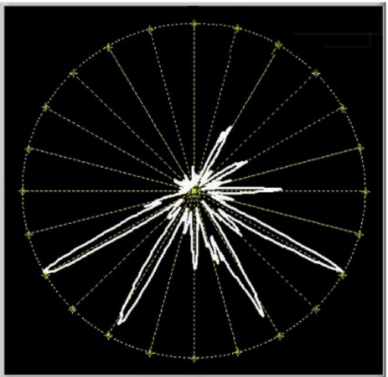
Figure 9. At this operation point, the impact of the stay vanes on the flow is decisive for cavitation.